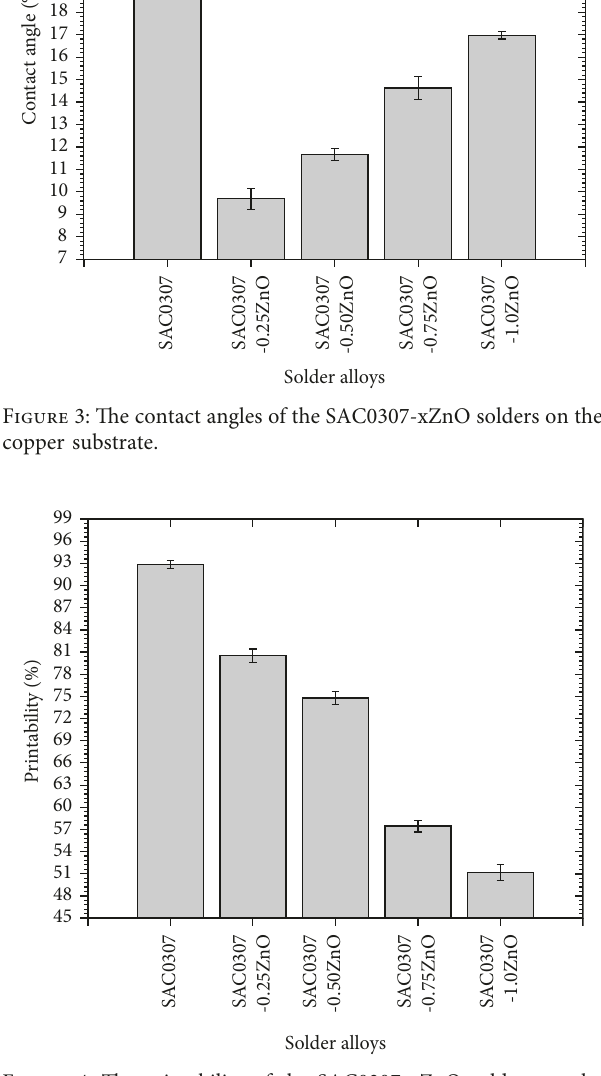
Figure 4: The printability of the SAC0307-xZnO solders on the copper substrate.